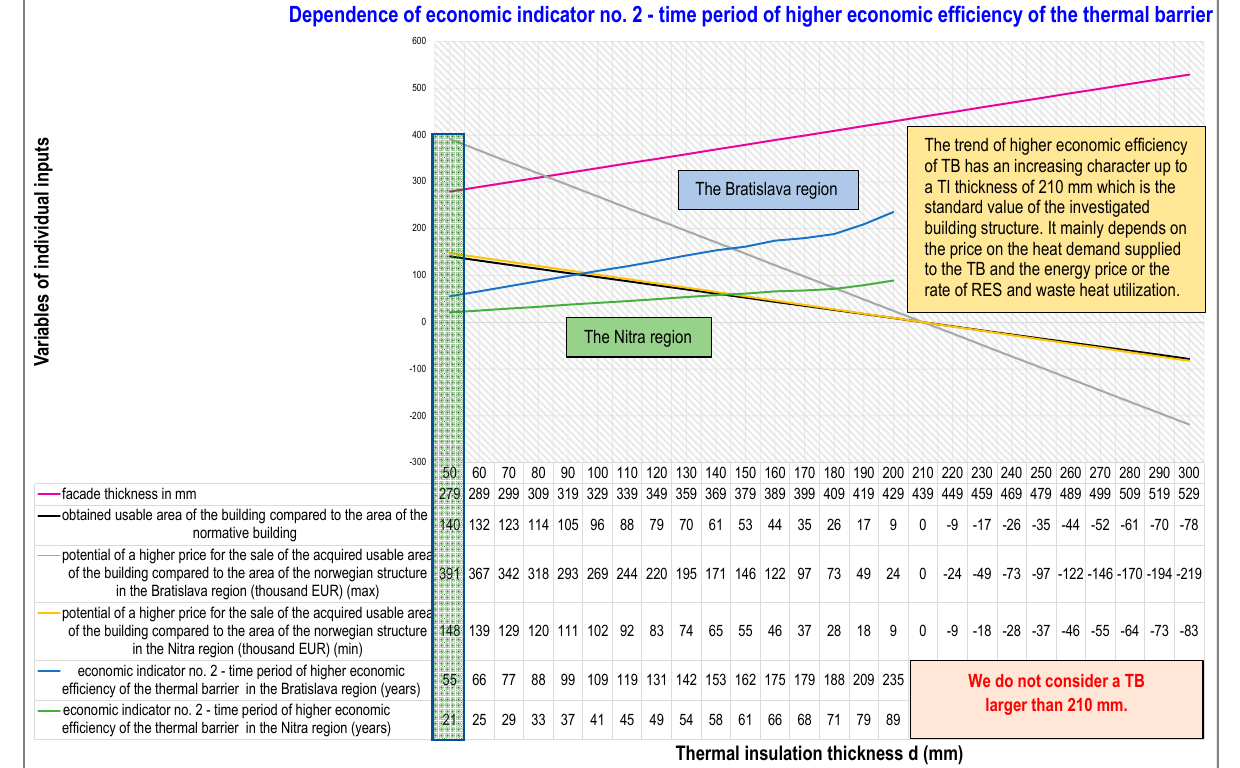
Figure 15. Dependence of economic indicator No. 2—the relationship between the higher selling price of the building and the heat for thermal barrier (TB).